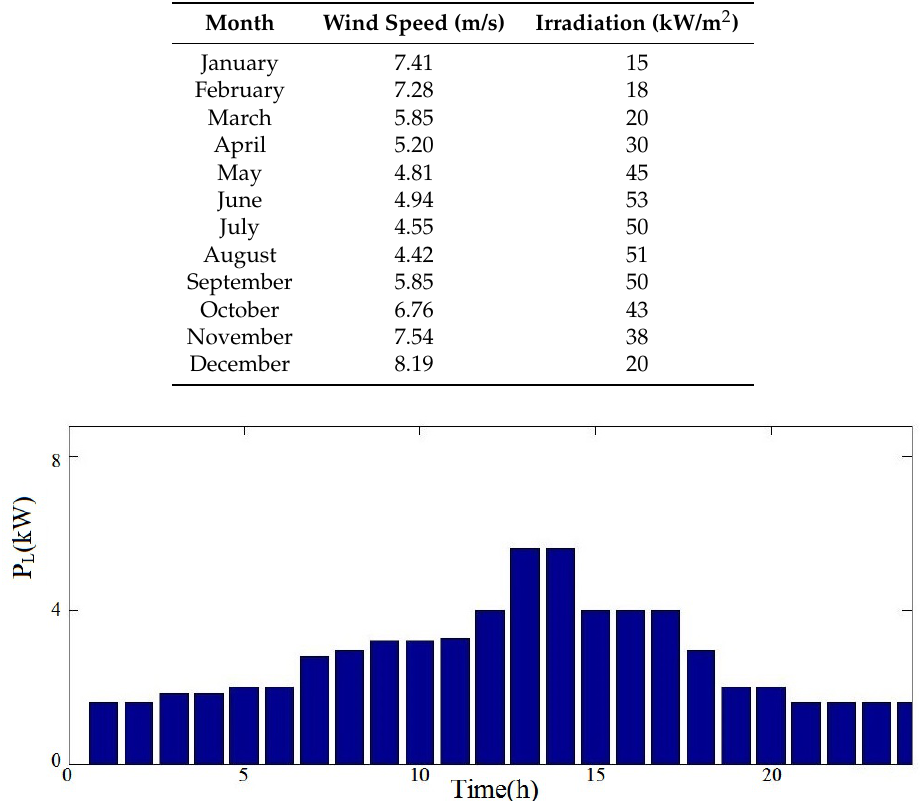
Table 1. Average wind speed and irradiation.